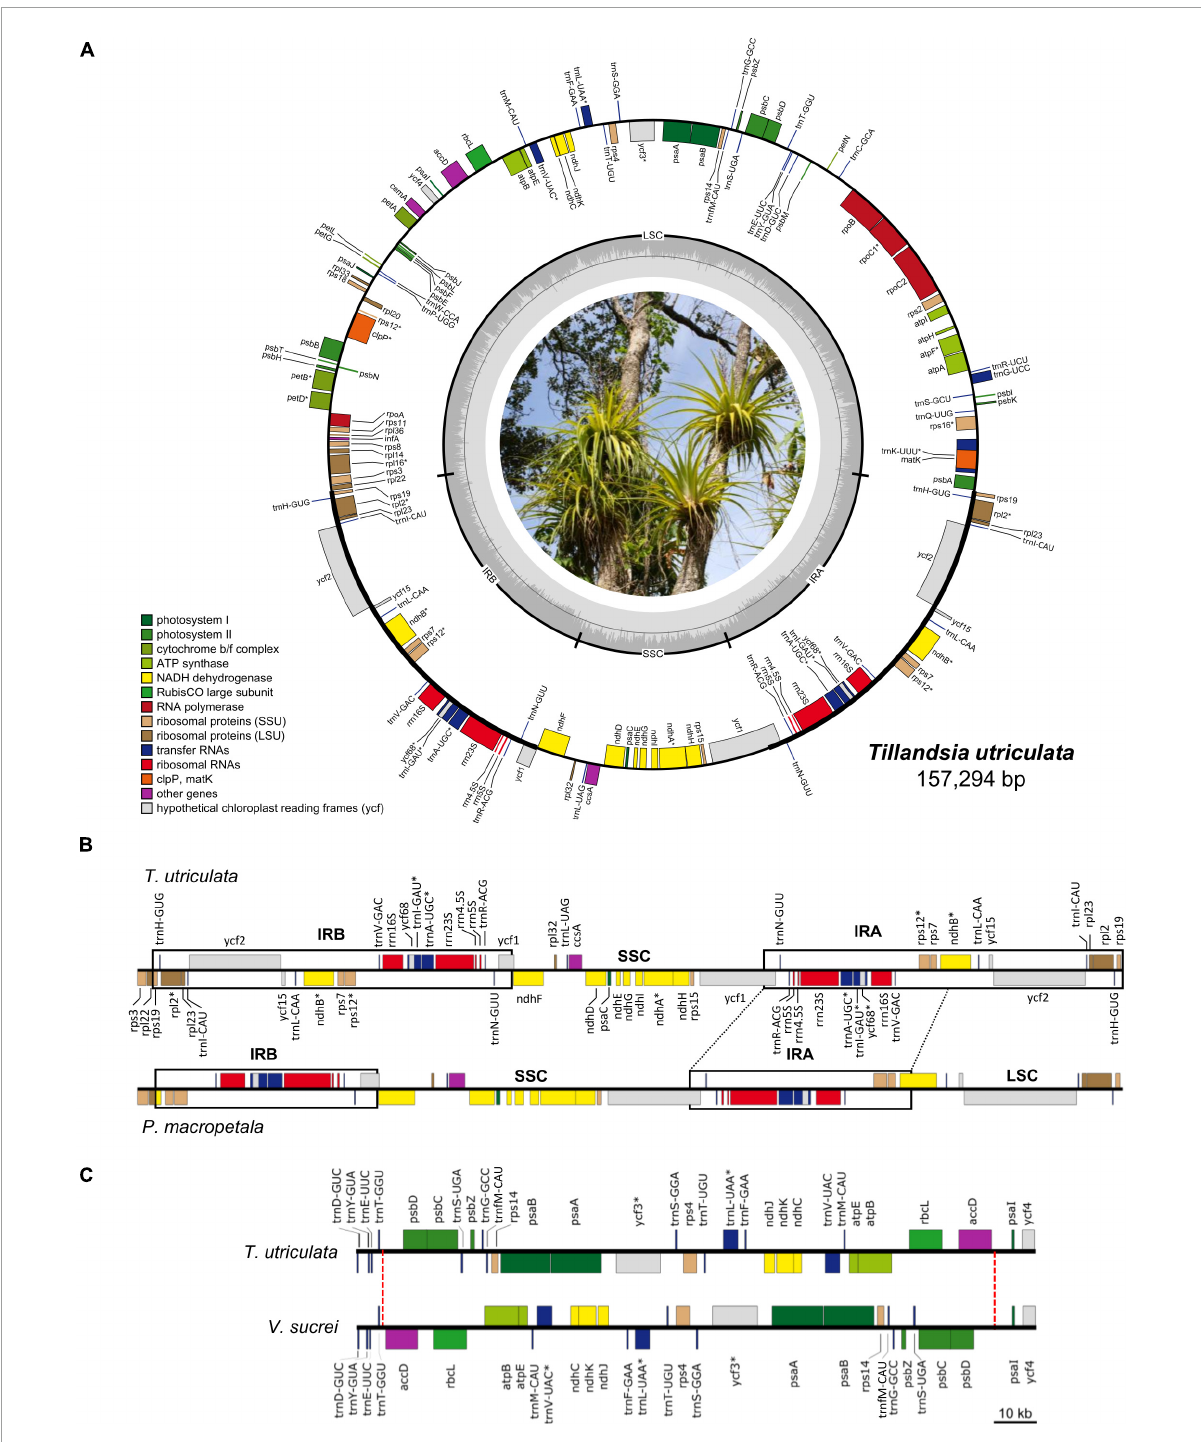
FIGURE1 (A) Circular representation of the Tillandsia utriculata plastome (Photo credit: Juan Pablo Pinzón). Genes are color coded according to their functional category and GC content across the plastome is denoted by the innermost gray circle, with the 50% threshold of GC content marked by a thin gray line. Genes that are transcribed counter-clockwise and clockwise are displayed to the outside and the inside of the outer circle, respectively. Genes with introns are denoted by an asterisk (*). (B) Comparison of the IRB-SSC-IRA region between T. utriculata and Pseudalcantarea macropetala , the latter showing a marked IR reduction and associated LSC expansion. One partial ( ndh B) and eight full ( rpl 2, rpl 23, rps 19, trn H-GUG, trn I-CAU, trn L-CAA, ycf 15, and ycf 2) genes are translocated from IR to the LSC region in Pseudalcantarea compared to other Tillandsioideae species. (C) Comparison of a portion of the LSC of T. utriculata and Vriesea sucrei . Vriesea species present a large inversion spanning from the partial trn T- acc D IGS to the partial psb D- psa I IGS (27,080 bp in V. sucrei ). The red dashed lines mark the boundaries of the